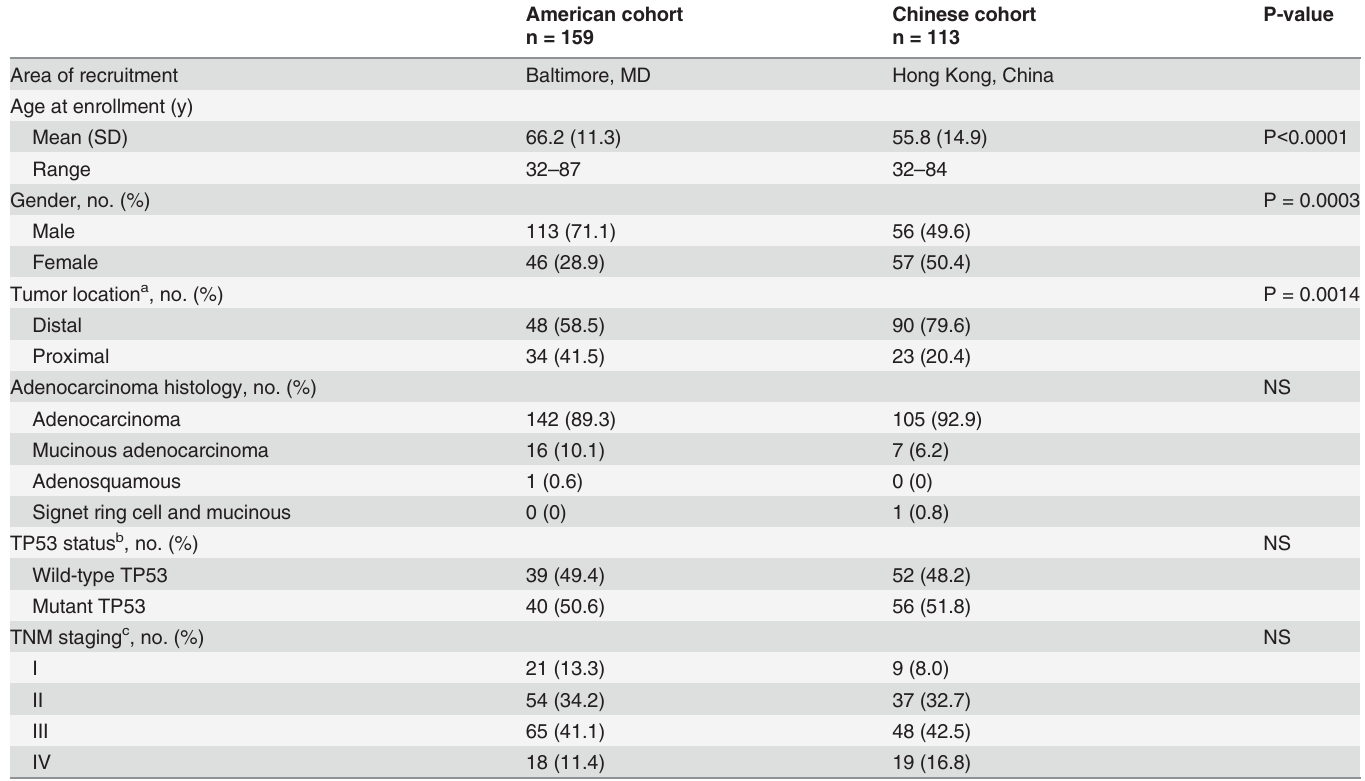
Table 1. Characteristics of study populations and